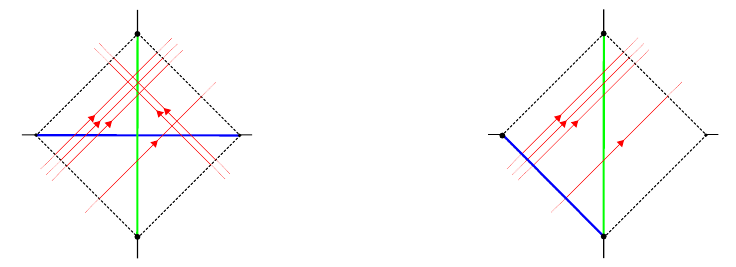
Figure 5 . Left: in a CFT, one can change a spatial interval (blue) into a time interval (green) using null paths, preserving information (cid:13)ow. Right: in a chiral (sector of a) CFT, one can move the endpoint of the interval (blue) along one of the null directions, e.g. up to the time interval (green), and preserve the information